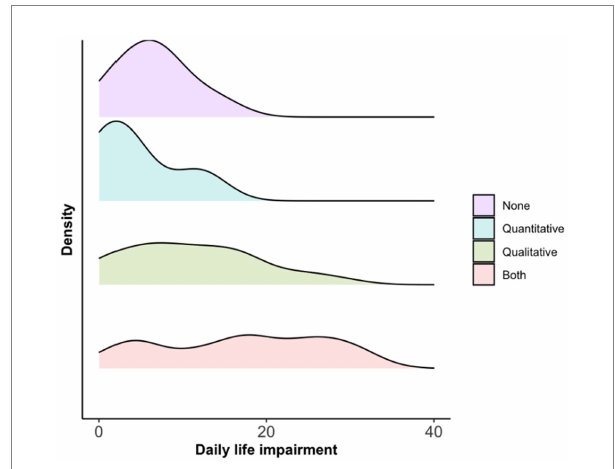
FIGURE 1 Density of distribution of average daily life impairment (QOD-NS score) assessments per olfactory dysfunction